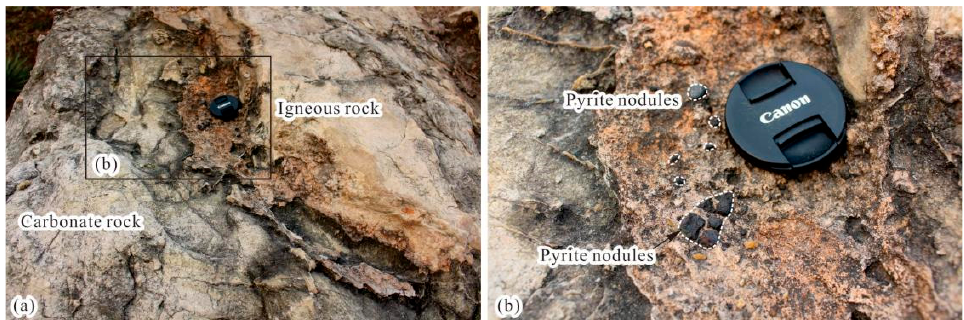
Figure 7. The pyrite nodules developed along the contact zones between the igneous rocks and the surrounding carbonate rocks. ( a ): The contact zone between the igneous rock and the surrounding carbonate rock; ( b ): The pyrite nodules developed along the contact zone.